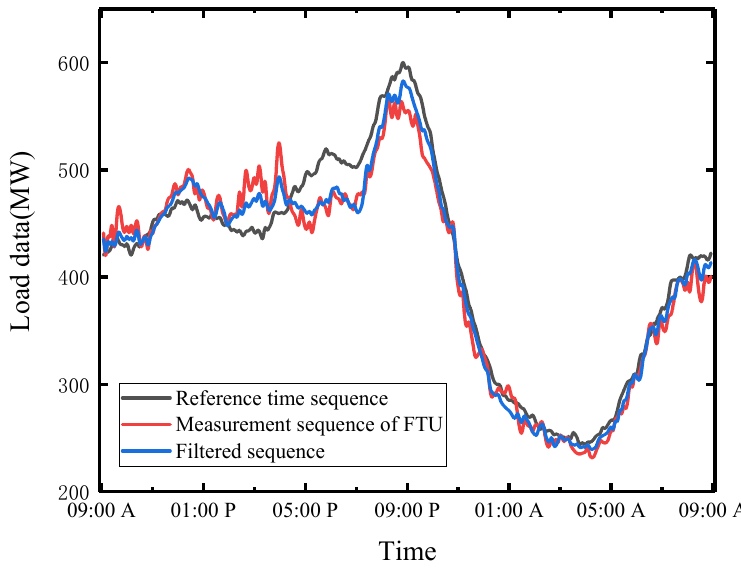
Figure 11. Active power curve to be cleaned based on reference time series filtering. In the same way, the TTU measurement active power curve determined by the shortest Euclidean distance is filtered based on its reference time series, and the result is shown in Figure 12.